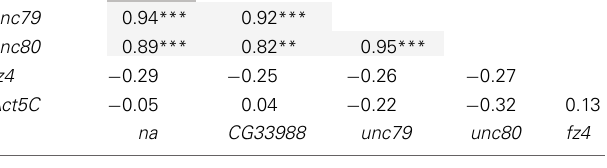
(B) Temporal gene expression